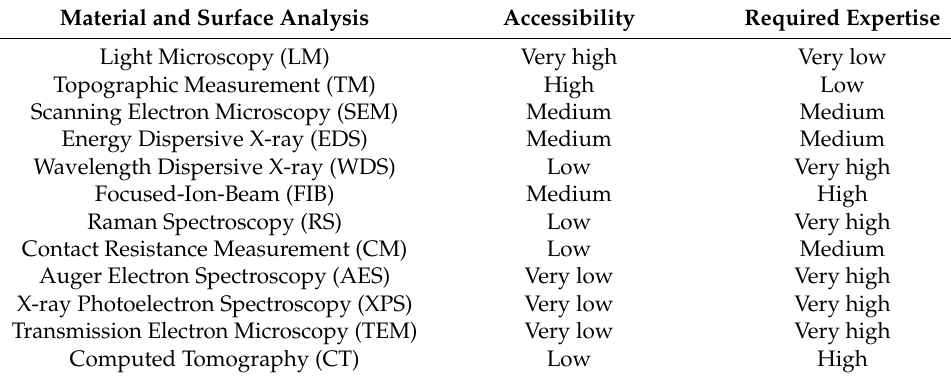
Table 4. Evaluation of the analytical methods with regard to accessibility and required expertise for the implementation and interpretation of the results.